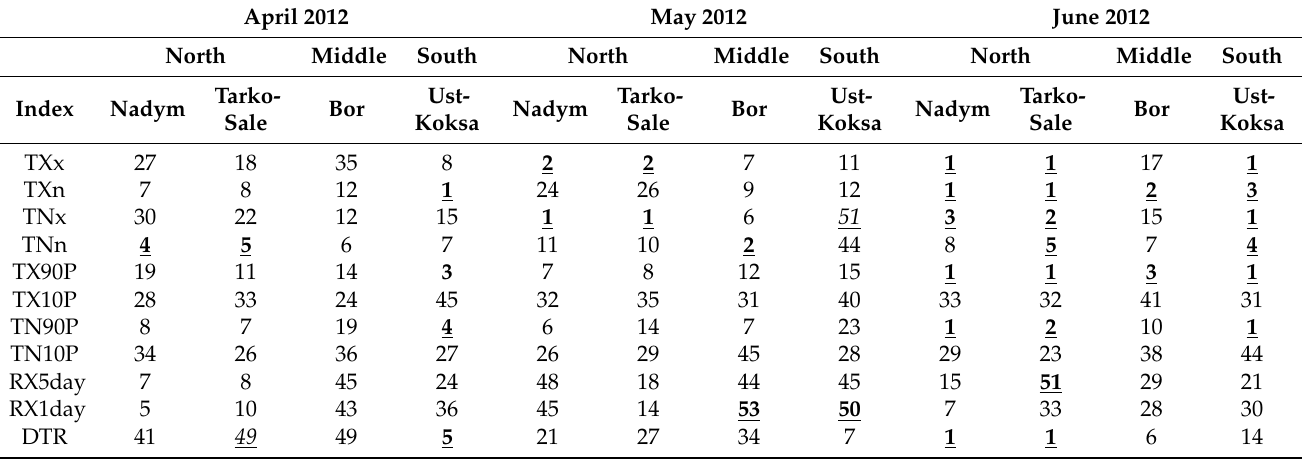
Table 4. Descending rank of monthly extreme indices from April to September in 2012 compared with those from 1966 to 2019. The climate normal was calculated from 1961 to